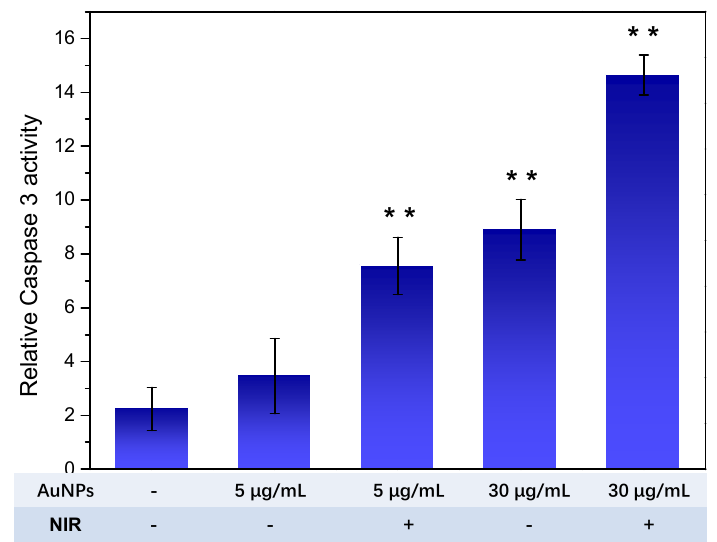
Figure 8. Relative Caspase 3 activity of MDA-MB-231 cells upon exposure to HA-capped AuNPs (with/without NIR treatment) at different concentration. ** p < 0.01 vs. negative control group.